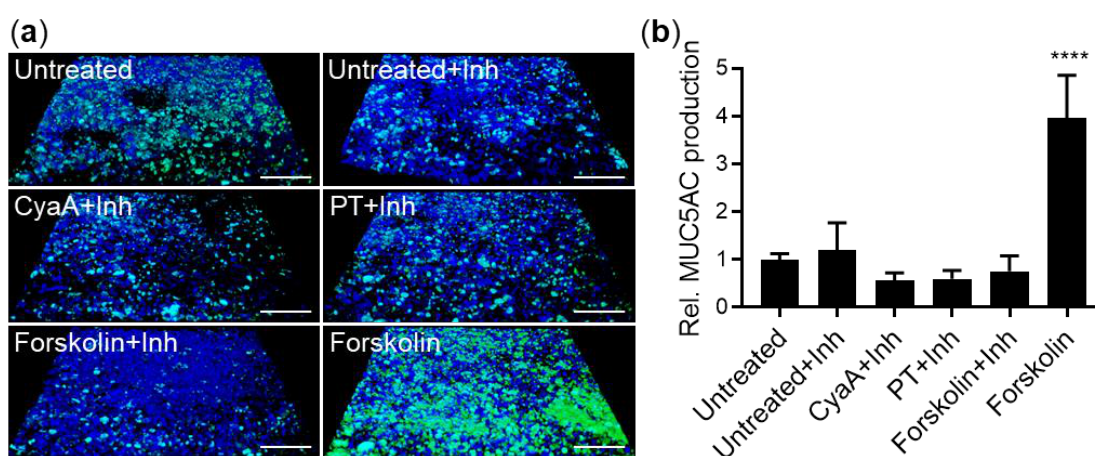
Figure 3. CyaA- and PT-mediated increase in mucin production is blocked by CREB inhibitor. ( a ) ALI-grown VA10 epithelial cell layers were pretreated from the basolateral side for 1 h with 10 µ M 666-15-Calbiochem inhibitor (Inh) of CREB-mediated gene transcription and then incubated with 100 ng/mL of CyaA, 100 ng/mL of PT or 20 µ g/mL of forskolin for 24 h at 37 ◦ C. The layers were fixed with 4% PFA, stained for Muc5AC (green) and analyzed by confocal microscopy. Nuclei were stained with DAPI (blue) and the VA10 cell layer treated with 20 µ g/mL of forskolin without the inhibitor is shown as a positive control. Scale bars correspond to 100 µ m on x-axis at the front edge. ( b ) Muc5AC staining was quantified on representative images using the software ImageJ. Bars represent means with SEM of relative Muc5AC production from at least three independent experiments. ****, p < 0.0001 compared with untreated cell layers.